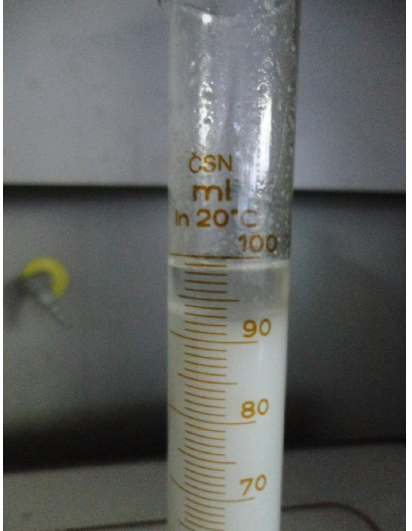
Figure 4. PX27 mixed with warm water.